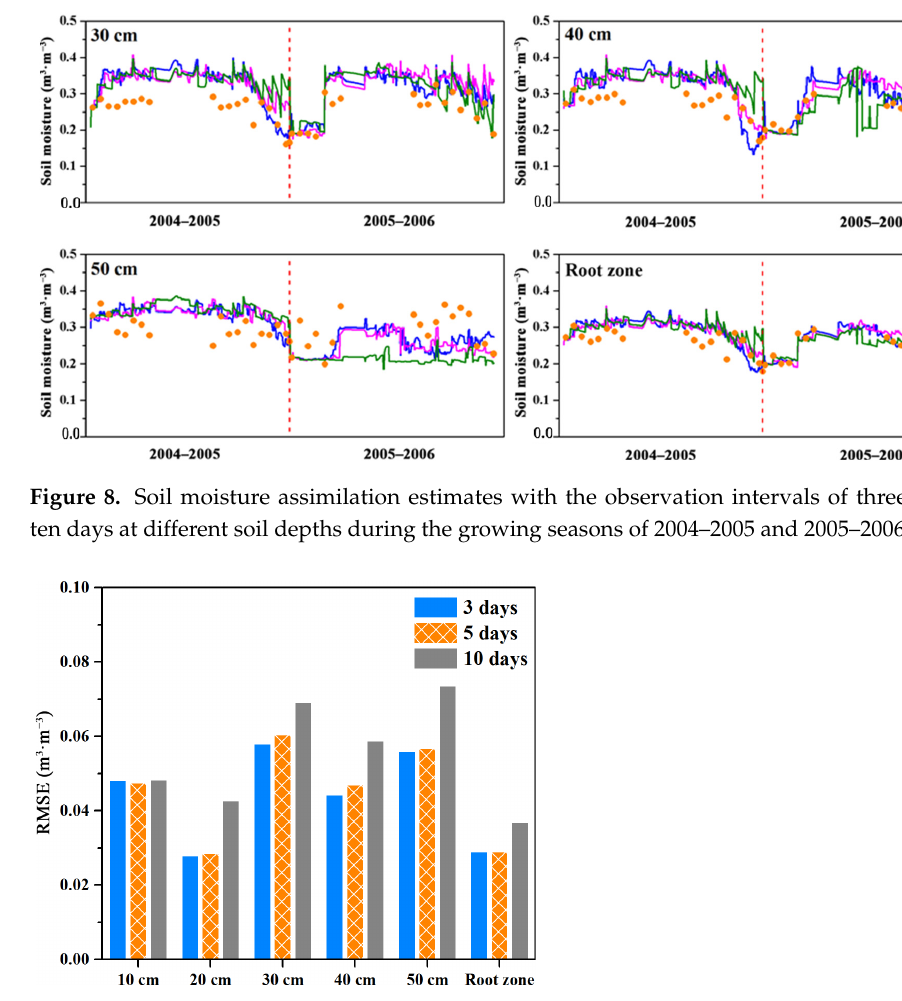
Figure 9. Comparison of the RMSEs of assimilated soil moisture with observation intervals of three, five, and ten days at different soil depths.